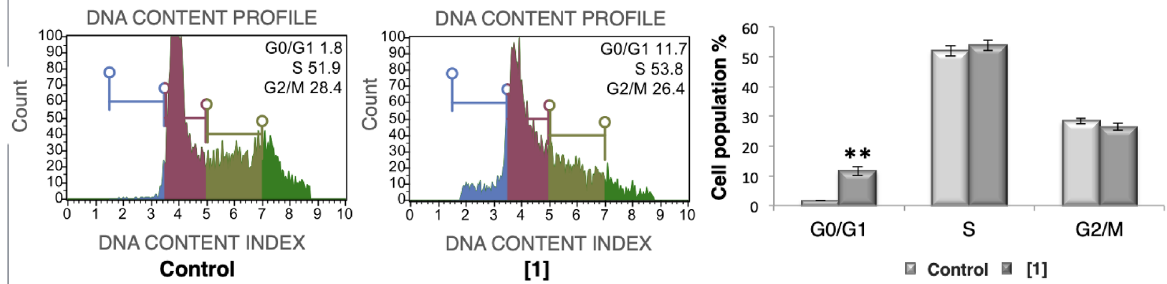
Figure 2. The results of cell cycle analysis. The A549 cells were plated on 12-well plates at a density of 2x10 5 cells/ well and treated with 3.432 mg/mL of hexane extract from the root [1] for 24 hr and cell cycle assay was performed according to the instructions as described in the methods section. Later, the cell population percent at different phases of the cell cycle, including G0/G1, S, and G2/M, were detected by Muse Cell Analyzer (Millipore, Germany). The results were given for three independent experiments. The differences are ** from control (p<0.0001).